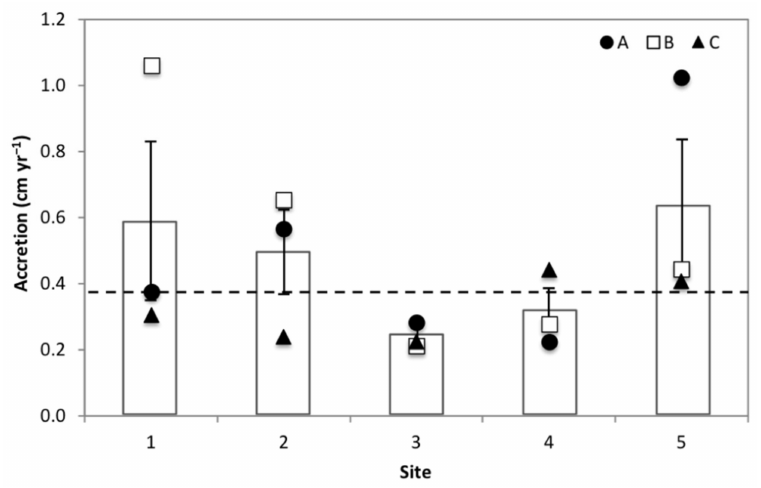
Figure 5. Accretion rates (cm yr − 1 ) for each site along the Nanticoke River (mean ± SE). Symbols indicate accretion rates for each subsite. Dotted line indicates RSLR for Cambridge, Maryland (0.377 cm yr − 1 ) from 1943 to 2018 obtained from http://www.tidesandcurrents.noaa.gov/ accessed on 13 May 2019. Table 2. Vertical accretion, bulk density and organic matter (averaged over 100 cm core ( n = 10)), accumulation rates, and the percent of accretion that is contributed by organic (Org) and inorganic matter (Inorg) and water/porespace (W/P) for each subsite along the Nanticoke